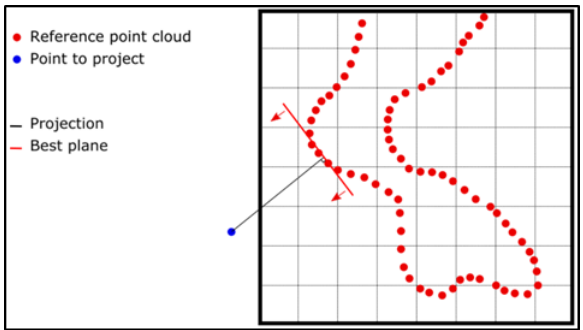
Figure 5. 3D projection option for the 3D Reshaper clouds inspection: the local plane is the closest one along the normal direction.